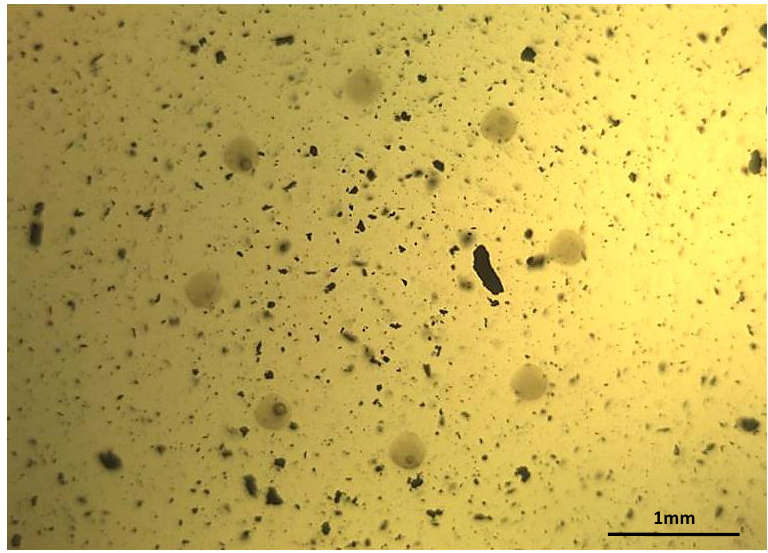
Figure 1. Image of a real lubricant sample from a gearbox in a wind mill, where large and small particles can be observed suspended in the fluid. The presence of this wear was evidencing a failure.